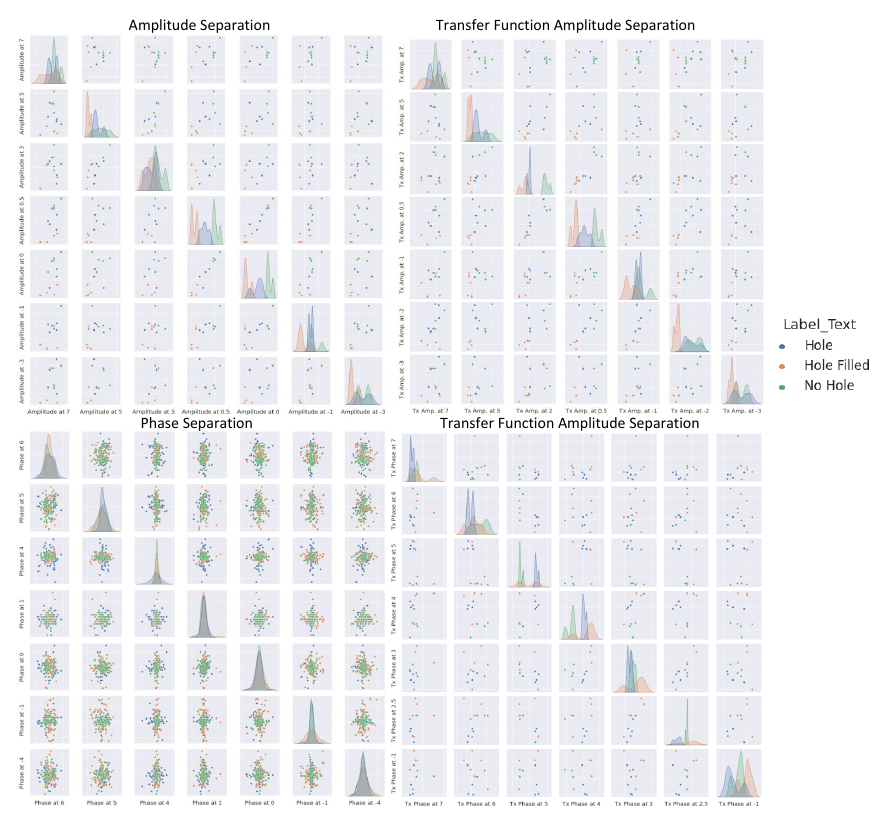
Figure 23. The separation matrices for the Amplitude data ( top left ), the Transfer Function Amplitude data ( top right ), the Phase data ( bottom left ), and the Transfer Function Phase data ( bottom right